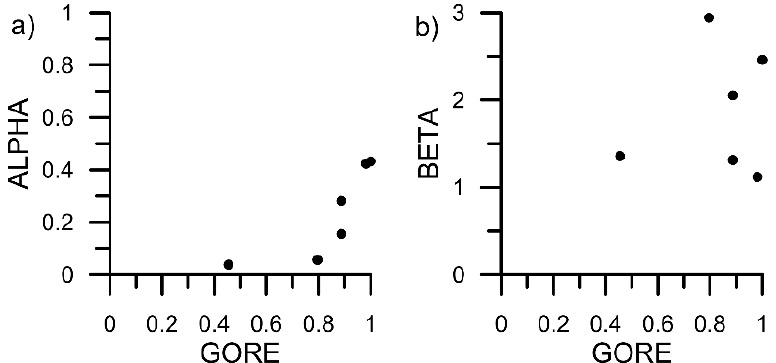
Figure 6. Sensibility of model parameters to rainfall quality (GORE). ( a ) For a parameter sensible, ALPHA and ( b ) for a parameter no sensible, BETA.